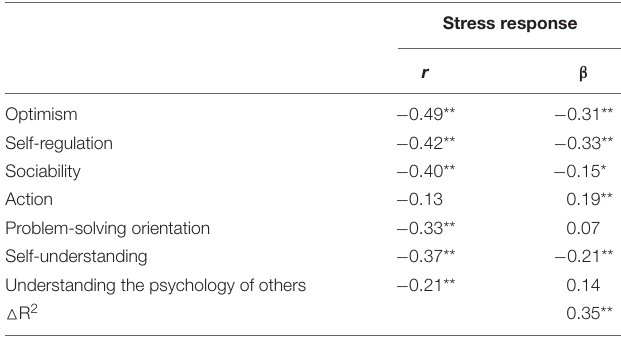
TABLE 4 | Correlation between resilience subfactors and stress responses and results of multiple regression analysis.